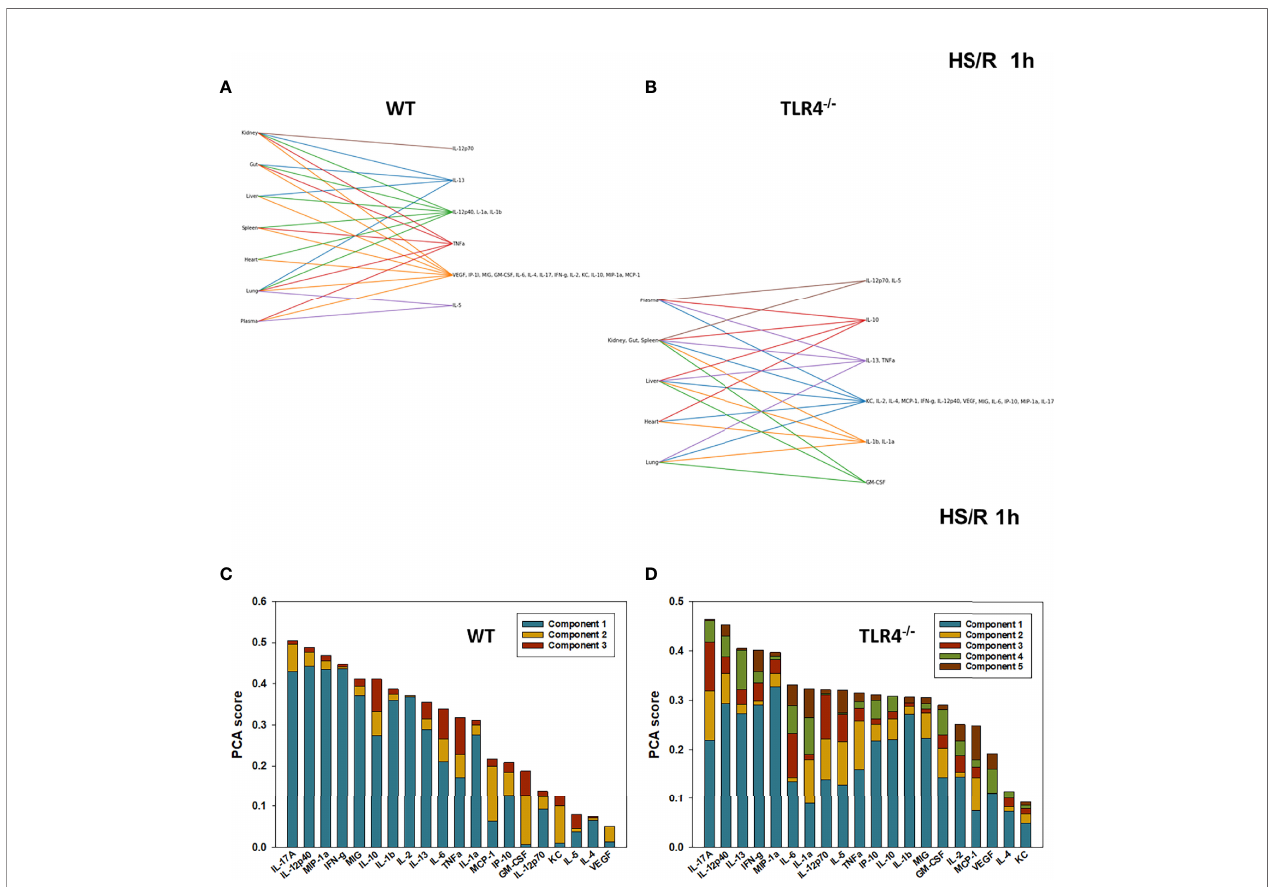
FIGURE 5 | Hypergraphs and Principal Component Analysis of in fl ammatory mediators from WT and TLR4 -/- mice subjected to HS/R (1h). Plasma and tissue samples from heart, lung, liver, gut, spleen, and kidney were collected from WT and TLR4 -/- mice subjected to HS/R (1h) and analyzed using Luminex ™ as described in Materials and Methods. Panels (A, B) show the hypergraphs and Panels (C, D) show the PCA results (70% variance) in WT and TLR4 -/- mice,